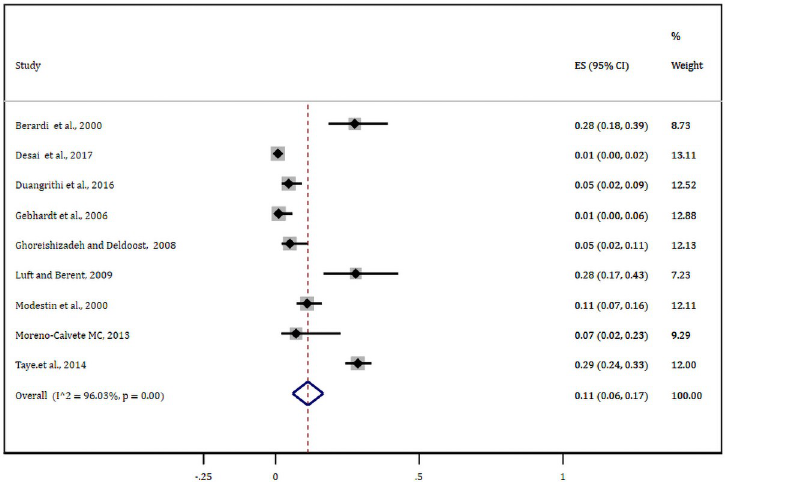
Fig 5. Forest plot depicting anti-psychotic induced